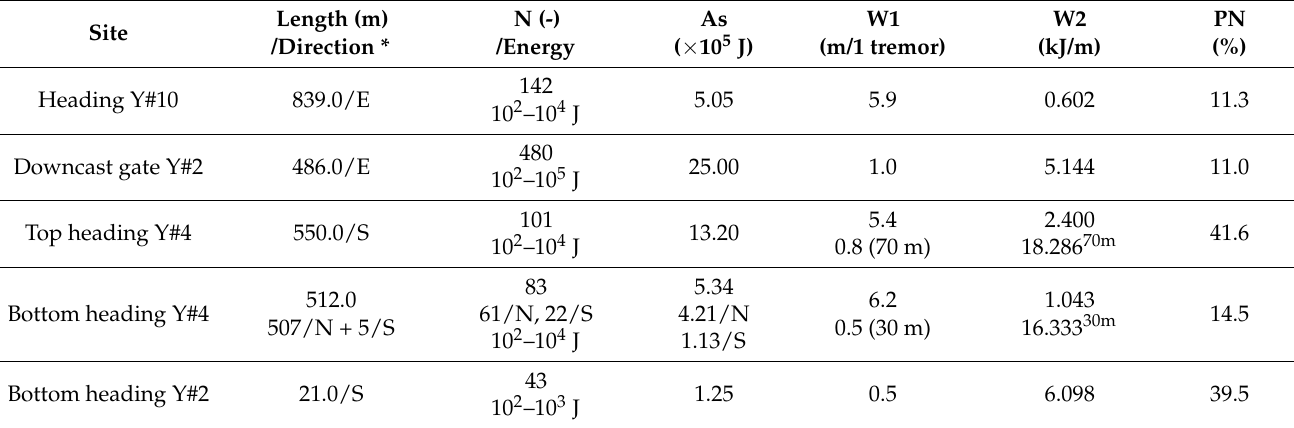
Table 2. Seismic activity data.